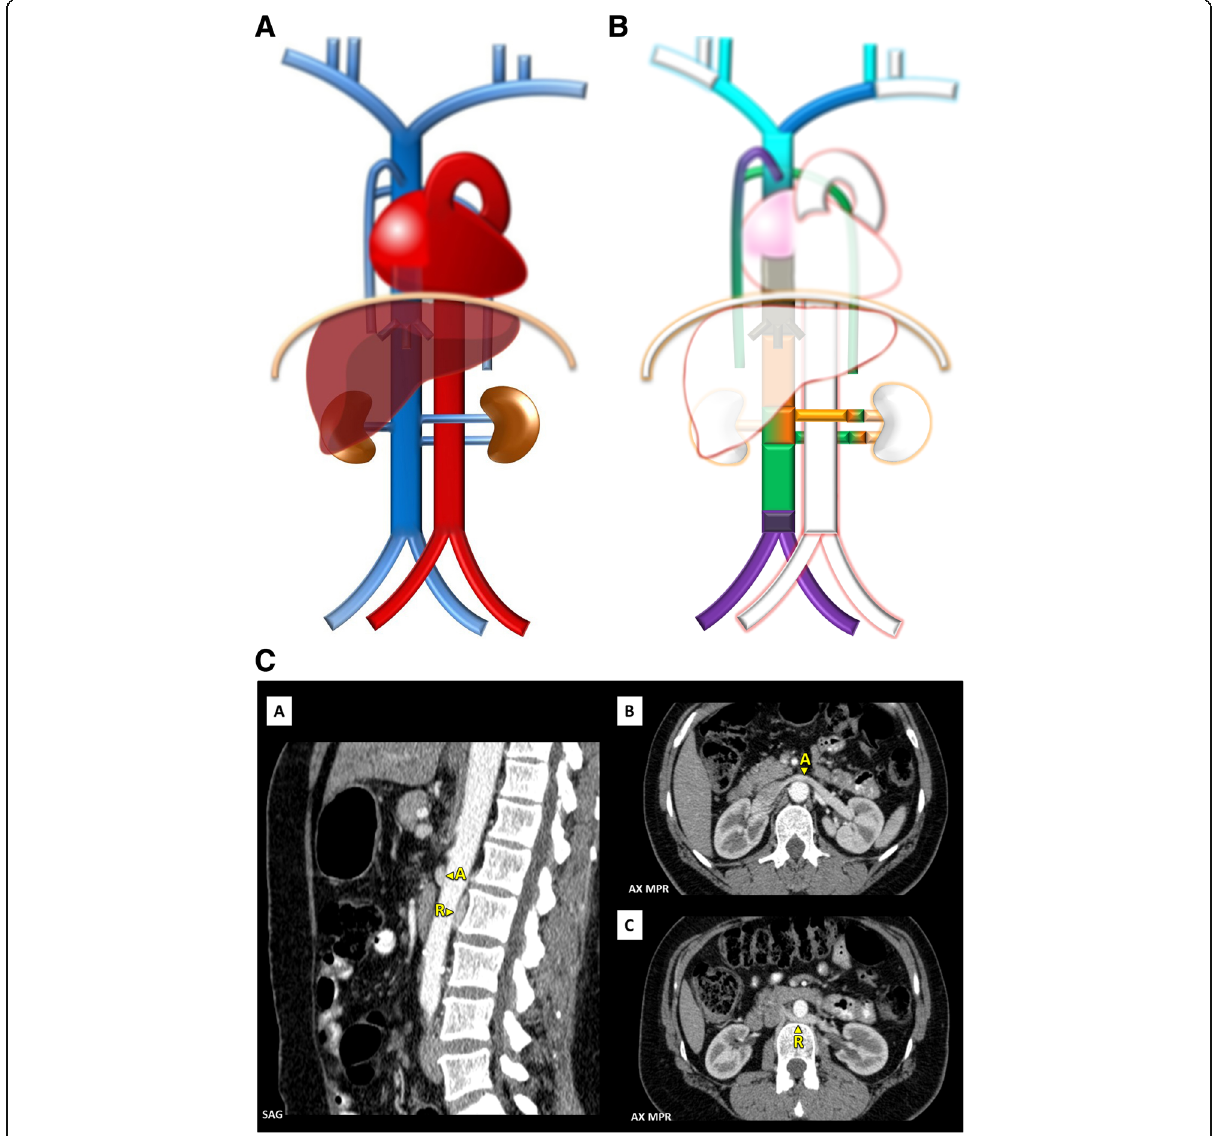
Fig. 10 a Circumaortic left renal vein schematic. In the case of the existence of two left renal veins, one superior, that crosses ventral to the aorta, and one inferior, that crosses dorsal to the aorta. b Circumaortic left renal vein embryology schematic. Showing the persistence of both venous arches of the left renal vein, one superior and ventral to the aorta, composed by the inter- sub cardinal anastomosis and ventral limbs of the left sub-supra cardinal anastomosis and left renal vein, and one inferior and dorsal to the aorta, composed by the inter- supra cardinal anastomosis, and dorsal limbs of the left sub-supra cardinal anastomosis and left renal vein. c Circumaortic left renal vein imaging. Contrast-enhanced CT presentation of a circumaortic left renal vein with an anterior left renal vein (A) and a retro-aortic left renal vein